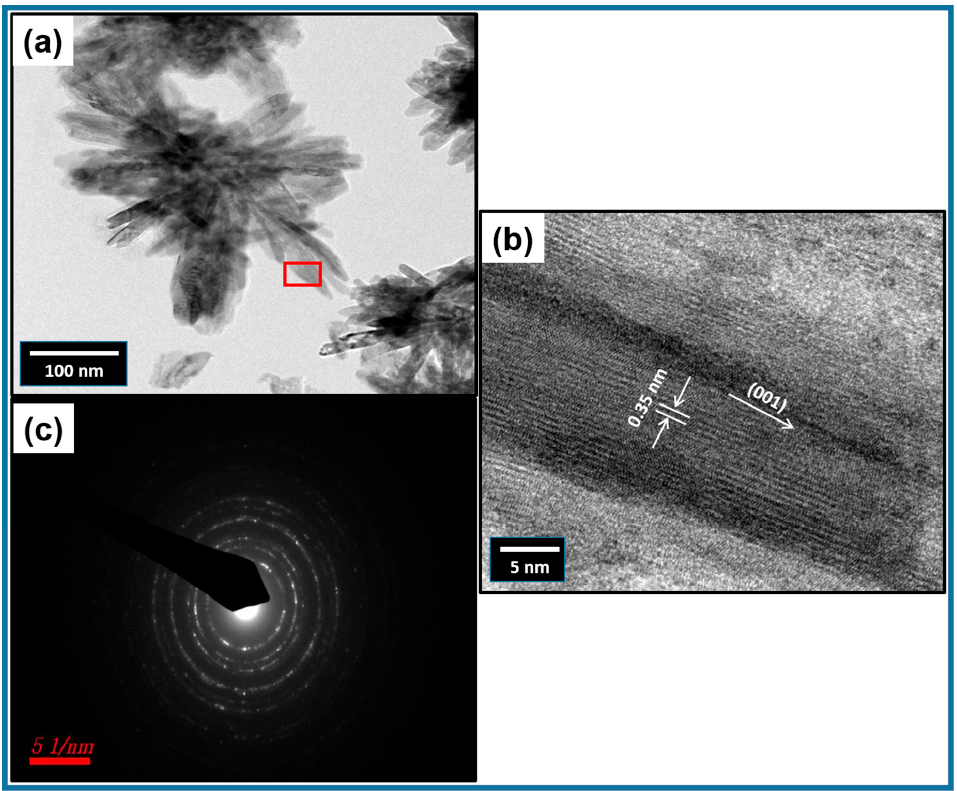
Figure 3. Typical ( a ) TEM, ( b ) HRTEM, and ( c ) SAED pattern of TiO 2 nanoflowers synthesized by facile low-temperature solution